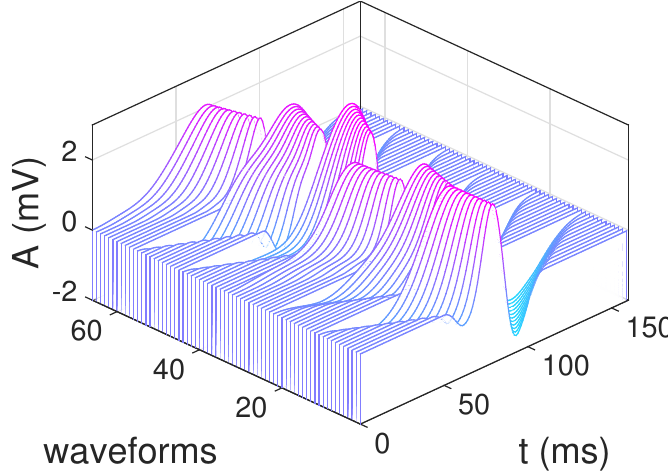
Figure 8. Multi-scale dictionary constructed using the K = 6 most representative waveforms shown in Figure